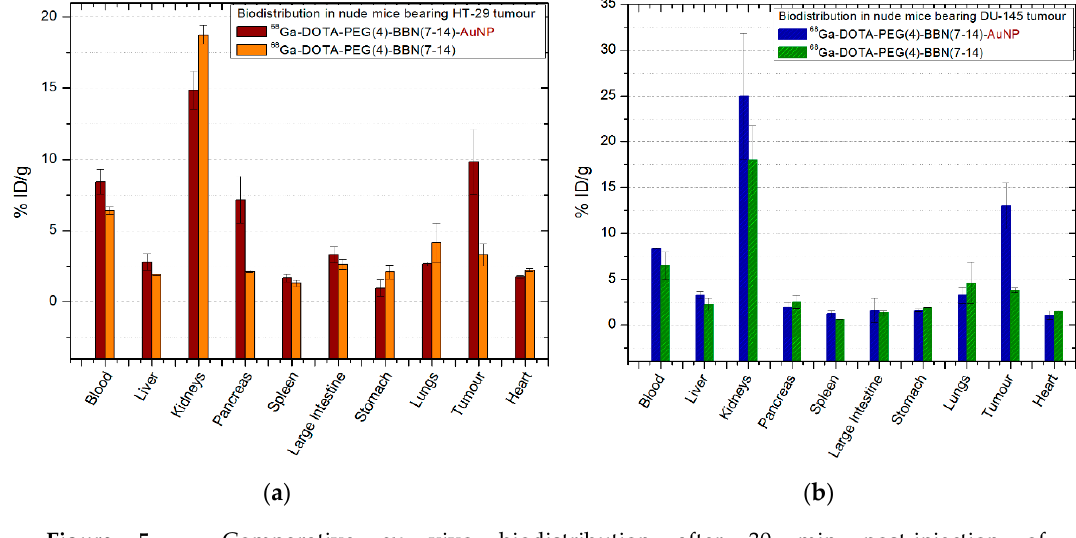
Figure 5. Comparative ex vivo biodistribution after 30 min post ‐ injection of 68 Ga ‐ DOTA ‐ PEG(4) ‐ Comparative ex vivo biodistribution after 30 min post-injection of 68 Ga-DOTA-PEG(4)-BBN(7-14) / 68 Ga-DOTA-PEG(4)-BBN(7-14)-AuNP: ( a ) in nude mice bearing BBN(7 ‐ 14)/ 68 Ga ‐ DOTA ‐ PEG(4) ‐ BBN(7 ‐ 14) ‐ AuNP: ( a ) in nude mice bearing colon tumour; ( b ) in nude mice bearing prostate tumour. Data are presented as mean ± SD ( n = 4).